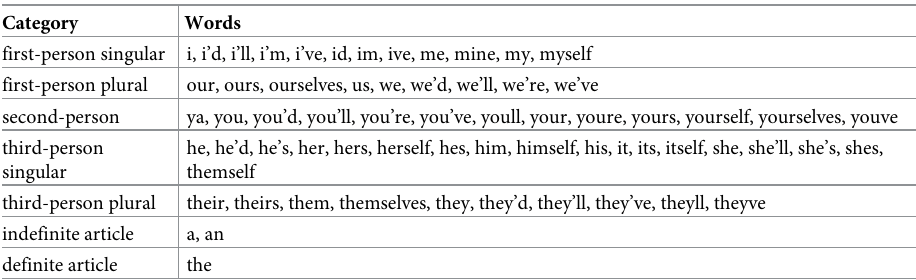
Table 2. Hypothesis word